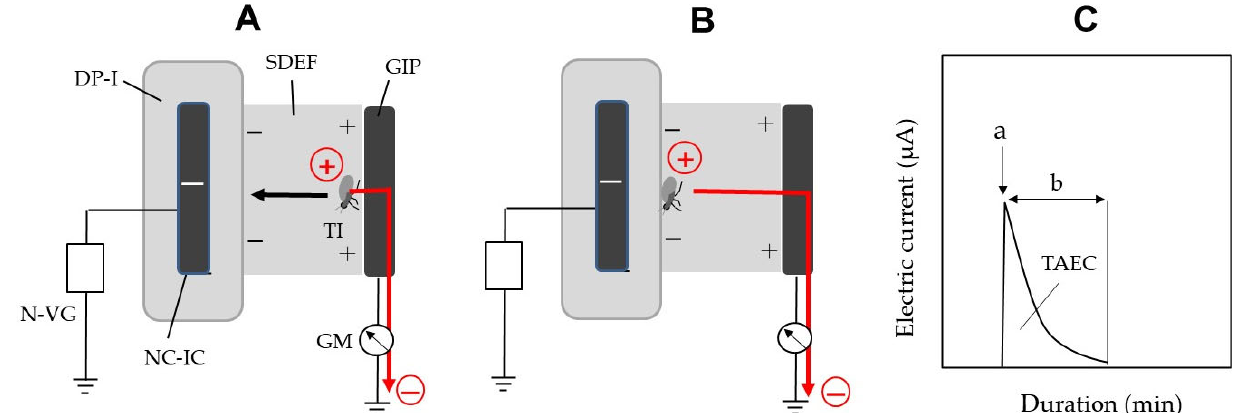
Figure 4. ( A , B ) Schematic representation of electric current generation by an insect upon its attraction to an insulated iron plate (NC-IC) ( A ) and during subsequent confinement to the charged plate ( B ). Red arrow indicates the direction of movement of free electrons pushed out of the insect body by the NC-IC. Black arrow indicates the direction of the attractive force drawing the positively electrified insect to the negatively charged insulated conductor. ( C ) Typical profile of electric current generated by an insect placed on the grounded iron plate. Arrows ‘a’ and ‘b’ indicate electric current produced by the insect upon its attraction to the negatively charged insulated iron plate and during subsequent confinement to the charged plate, respectively. The total amount of electricity released from the fly was calculated as the total amount of electric current (TAEC) ( µ A min) generated by the fly, according to the area bounded by the x-axis and the plotted curve of generated current. Abbreviations are provided in Figure 1.